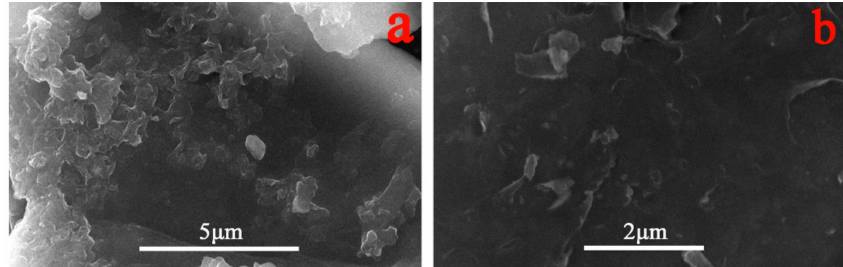
Figure 6. SEM images of PLA-2 nanocomposite films after combustion under different resolutions. ( a ) 5 µ m; ( b ) 2 µ